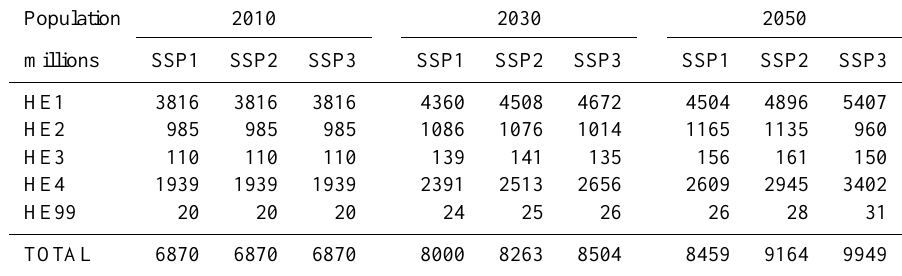
Table A2. Number of population belonging to the four hydro-economic (HE) quadrants under SSP1, SSP2, and SSP3 for the years 2010, 2030, and 2050, respectively. HE99 indicates territories that are not assigned to HE classes. Population 2010 2030 millions